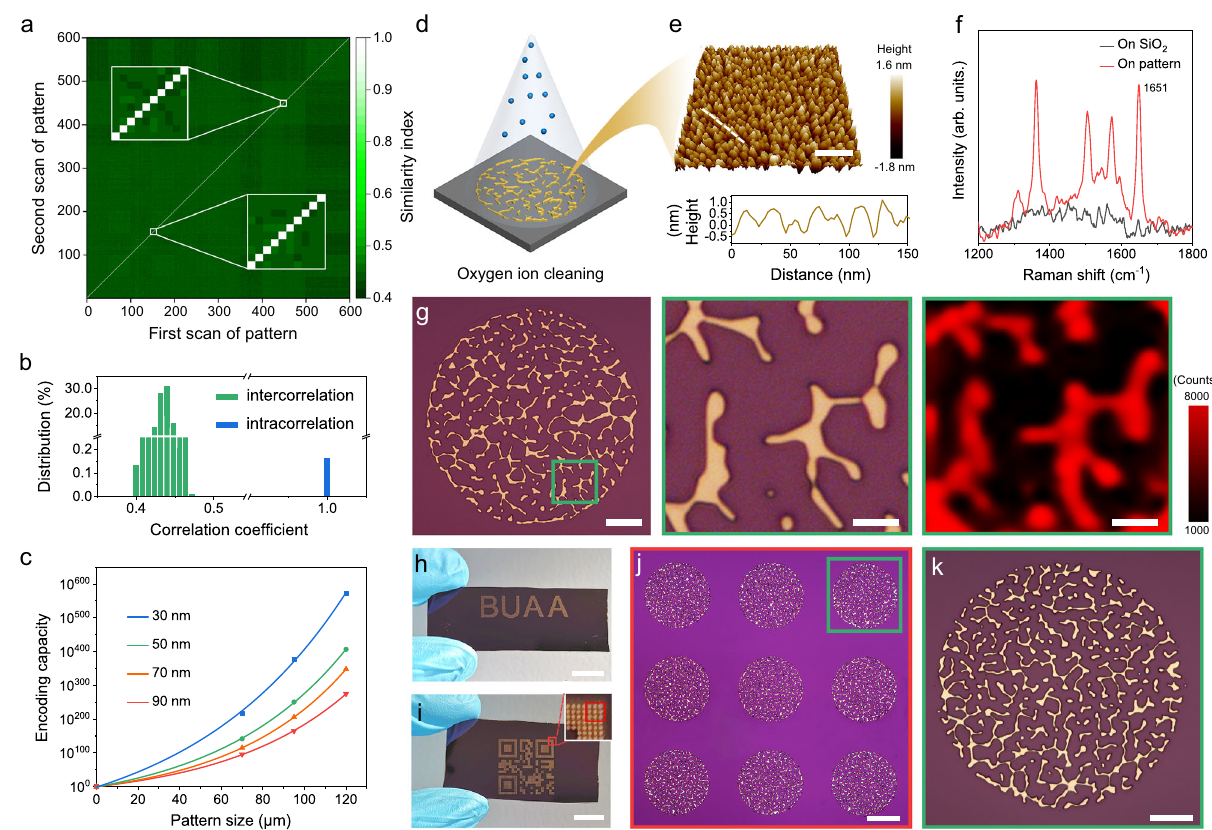
Fig. 3 | Individuality characterization and multiple-level security strategy of the PUFs. a Heat map showing the cross-correlation values obtained from 600 network patterns among the same fabrication batch. Each pattern was scanned twice, and calculations were carried out between these two image sets. The color bar represents the similarity index, the data along the diagonal line represent the values from the same images, and the others represent the values from different images. b Distribution of the correlation coef fi cients from ( a ). c Encoding capacity of the PUF tags with different fi lm thicknesses and pattern sizes, showing expo- nential growth in terms of the pattern size, which is well fi tted by the ExpDec 1 function. d Schematic illustration of the surface roughening process of the Au